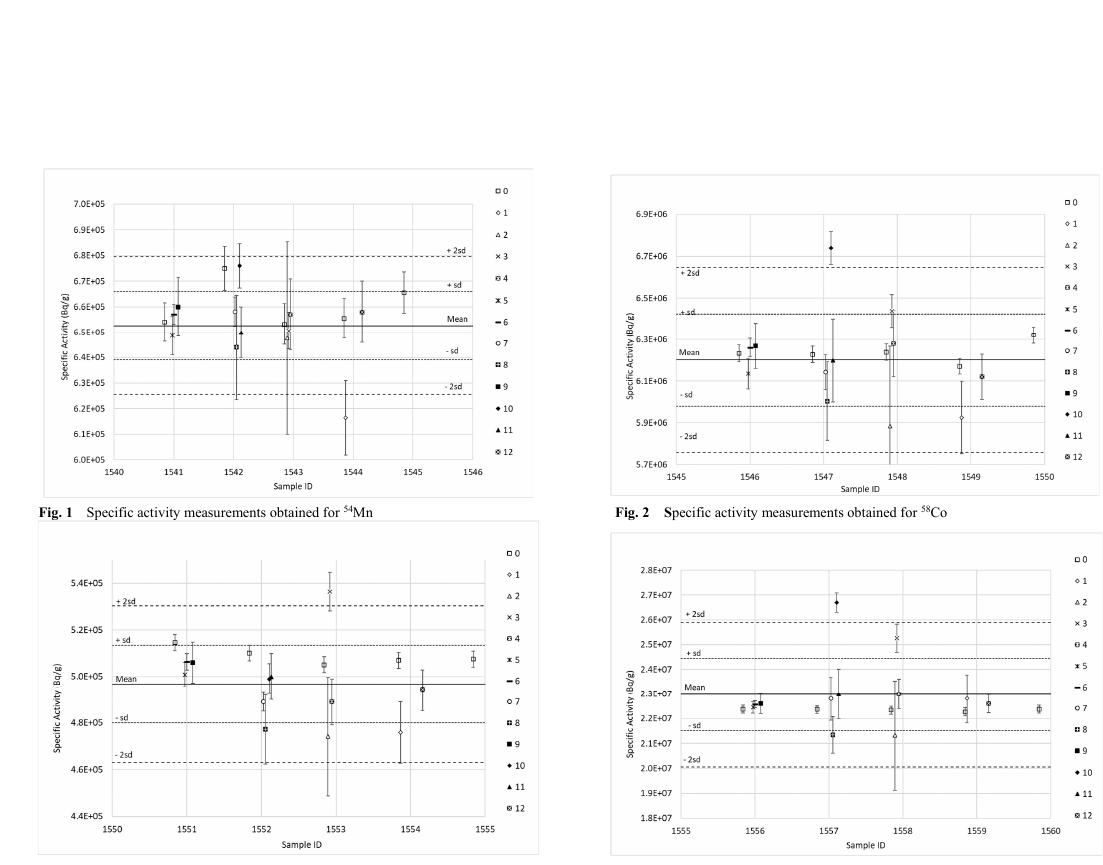
Fig. 3 Specific activity measurements obtained for 46 Sc Fig. 4 Specific activity measurements obtained for 60